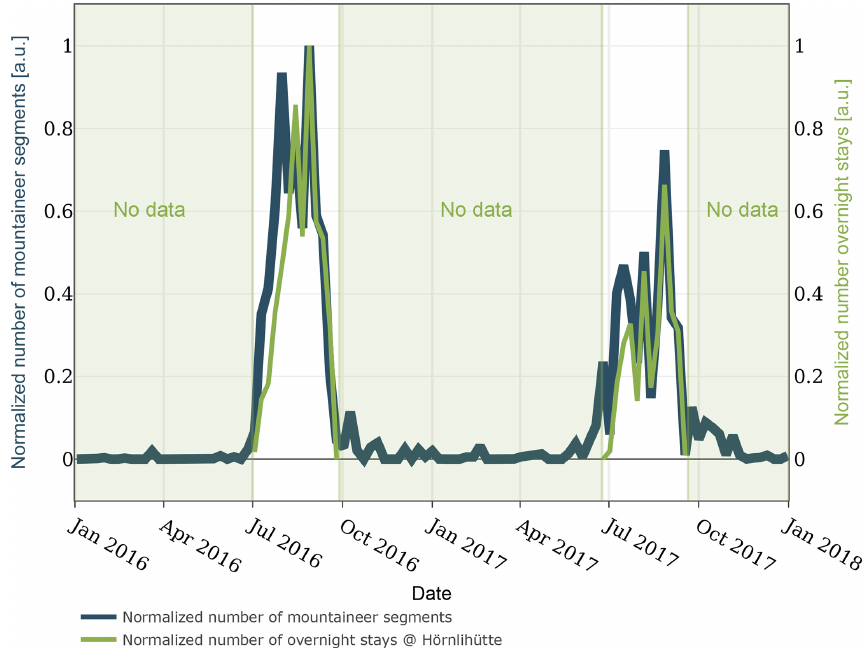
Figure 13. Correlation of mountaineer activity and hut occupancy. The normalized number of mountaineer segments per week and the normalized number of overnight stays at the Hörnlihütte per week is plotted over